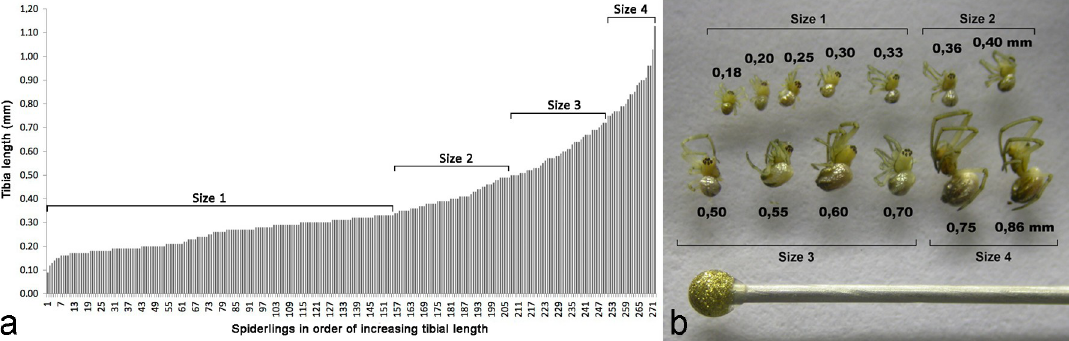
Fig 4. a. Leucauge argyra spiderlings in order of increasing tibial length showed a continuum in which no clear groups could be easily defined. The four body size categories are indicated. b. Examples of L . argyra spiderlings in the four body size groups, with their corresponding tibia lengths and the head of an insect pin for